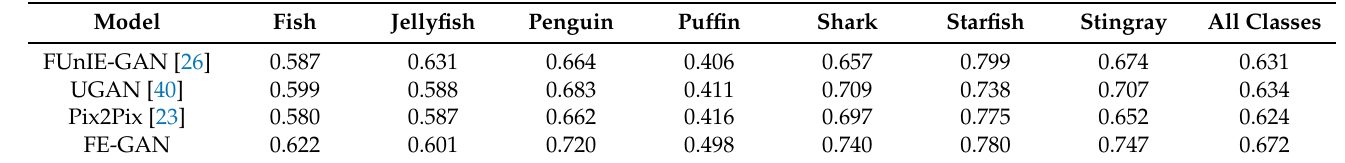
Table 6. The mAP comparison results of object detection with the state-of-the-art methods in the Aquarium Combined